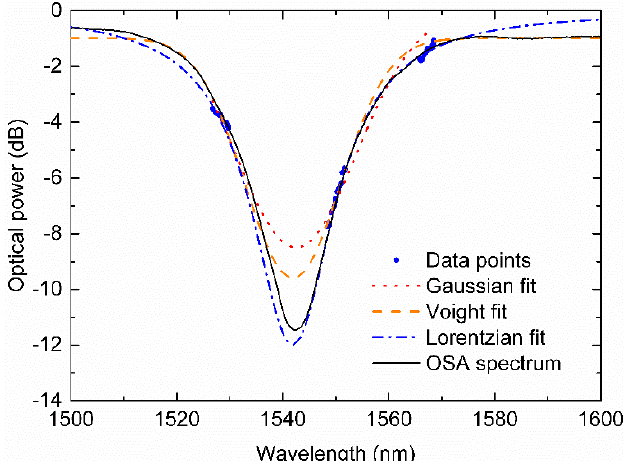
Figure 2. Comparison between several fitting curves for the acquired data points using the developed interrogation unit (IU) and, for validation purposes, the real LPFG spectrum measured by a typical optical spectrum analyzer (OSA) and broadband light sources (BBLS) scheme.